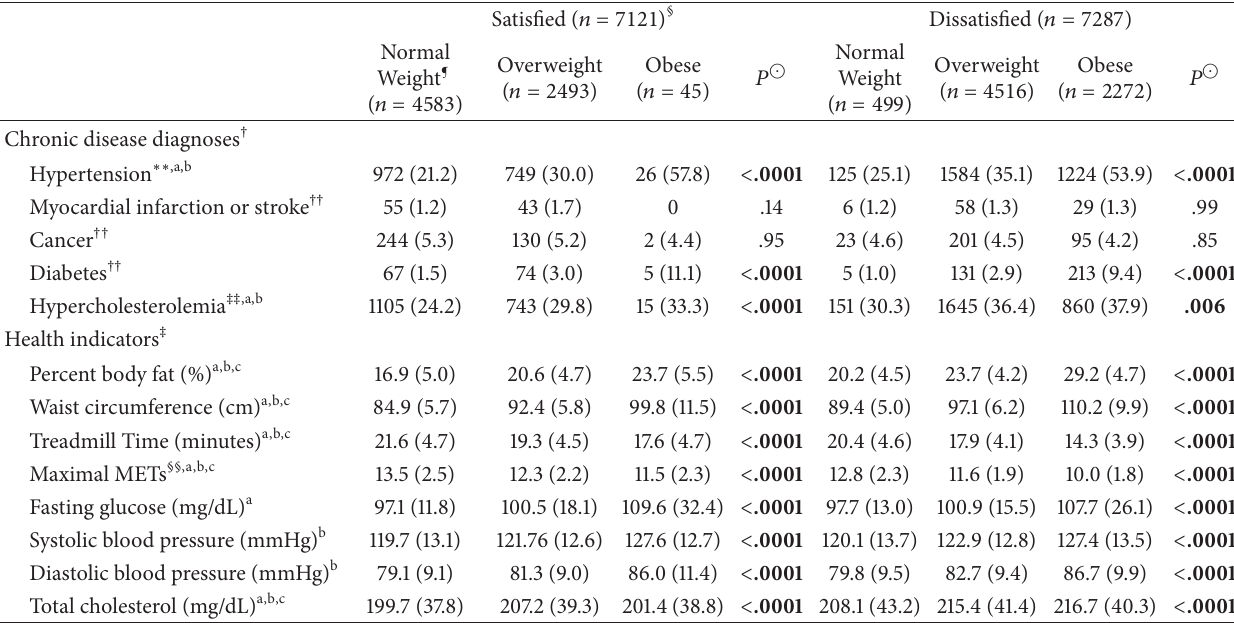
Table 5: Relationships between body weight satisfaction by overweight status and health indicators and history of chronic disease, Aerobics Center Longitudinal Study, 1987–2002: men ( 𝑛 = 14408 ) ∗ .